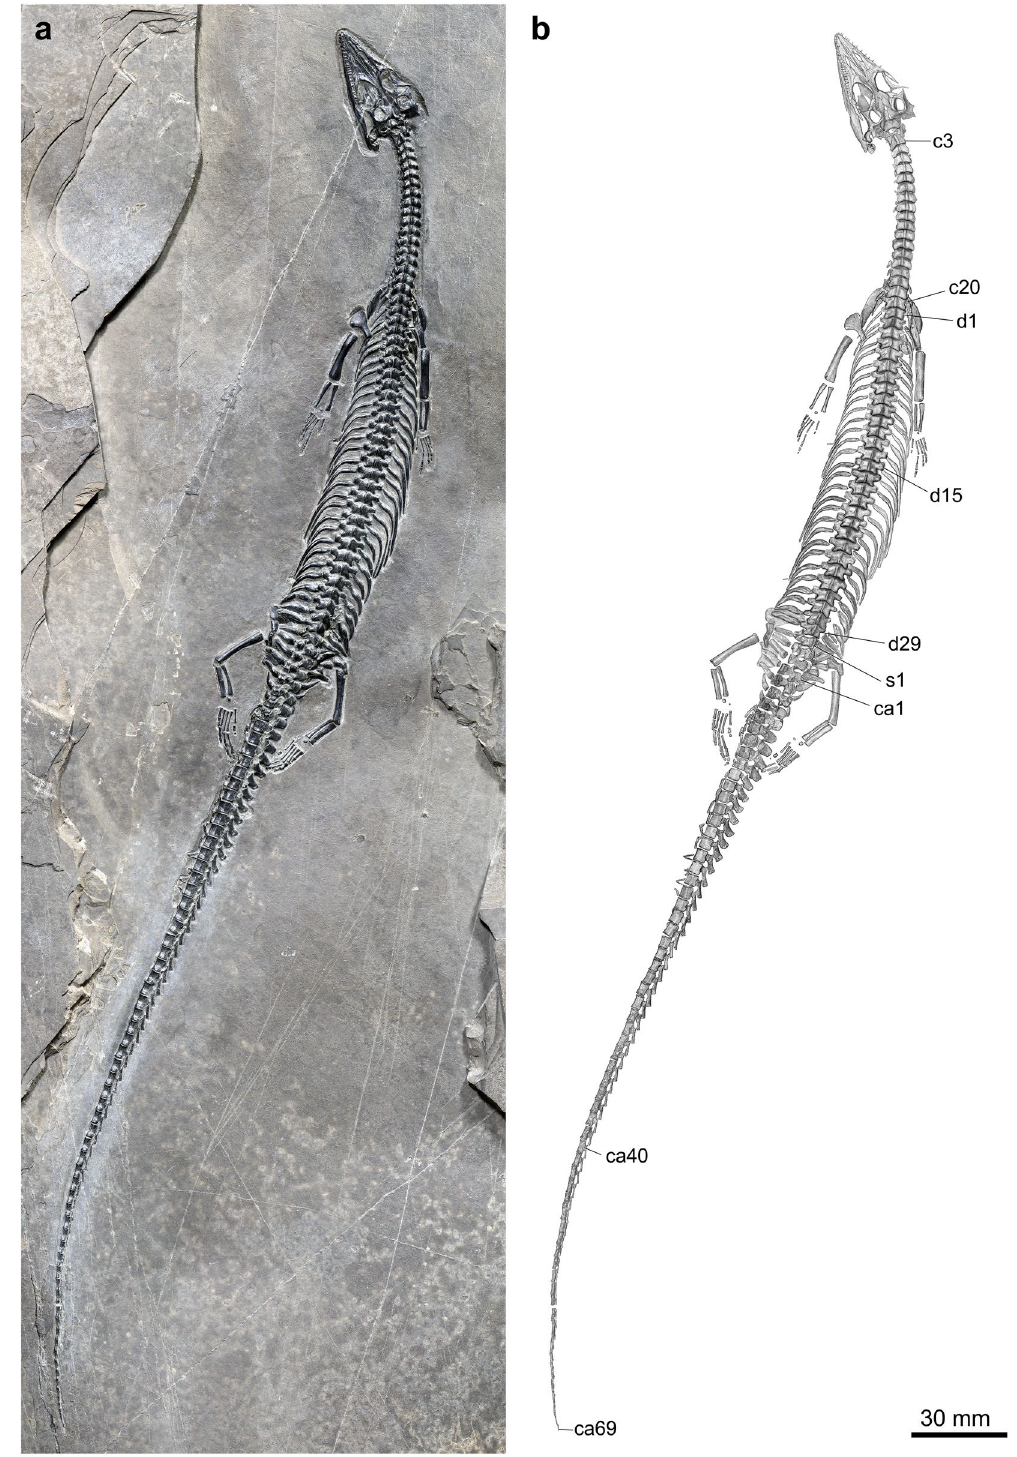
Figure 2. Honghesaurus longicaudalis gen. et sp. nov., Holotype (IVPP V30380). Photo ( a ) and line-drawing ( b ) of whole specimen. c, cervical vertebra; ca, caudal vertebra; d, dorsal vertebra; s, sacral